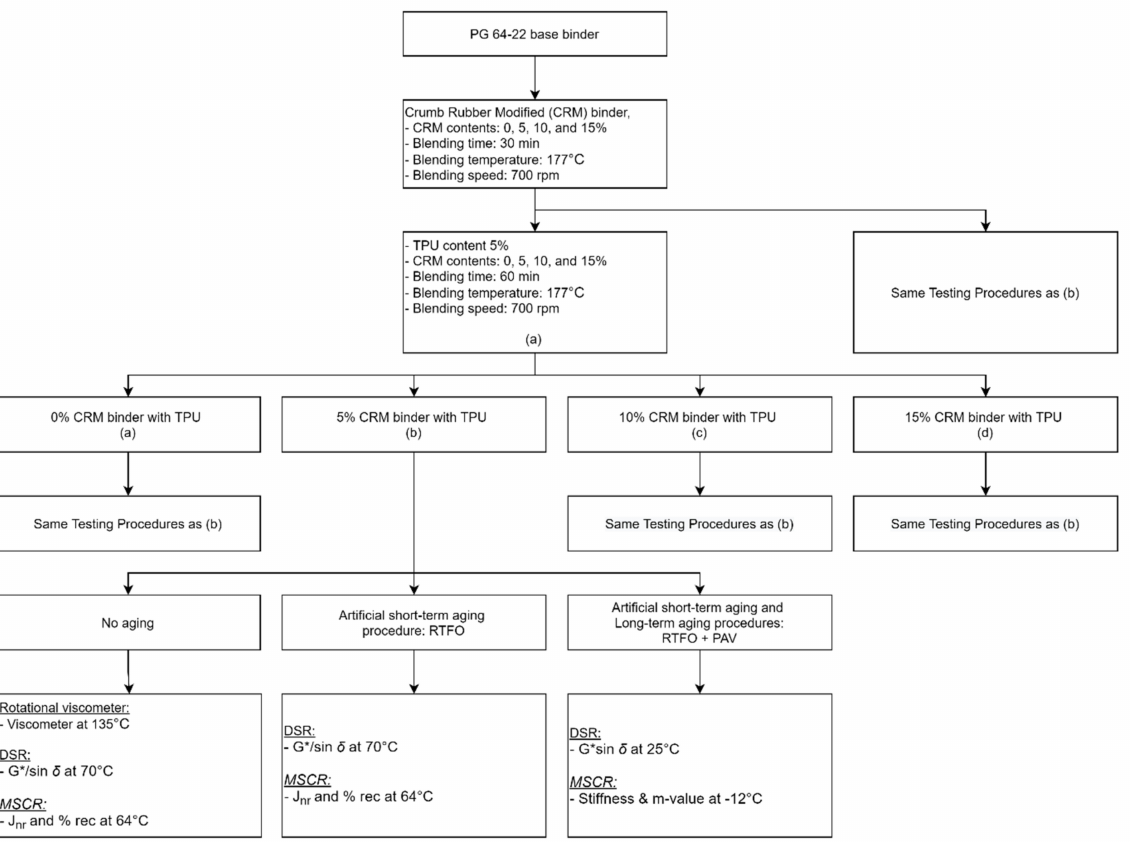
Figure 1. Flow chart of experimental design